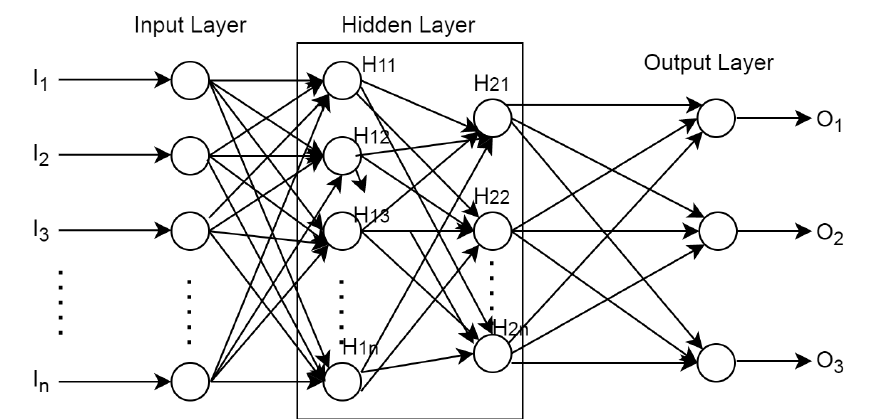
Figure 4. An Artificial Model (combines LM and Viterbi Algorithms to ensure